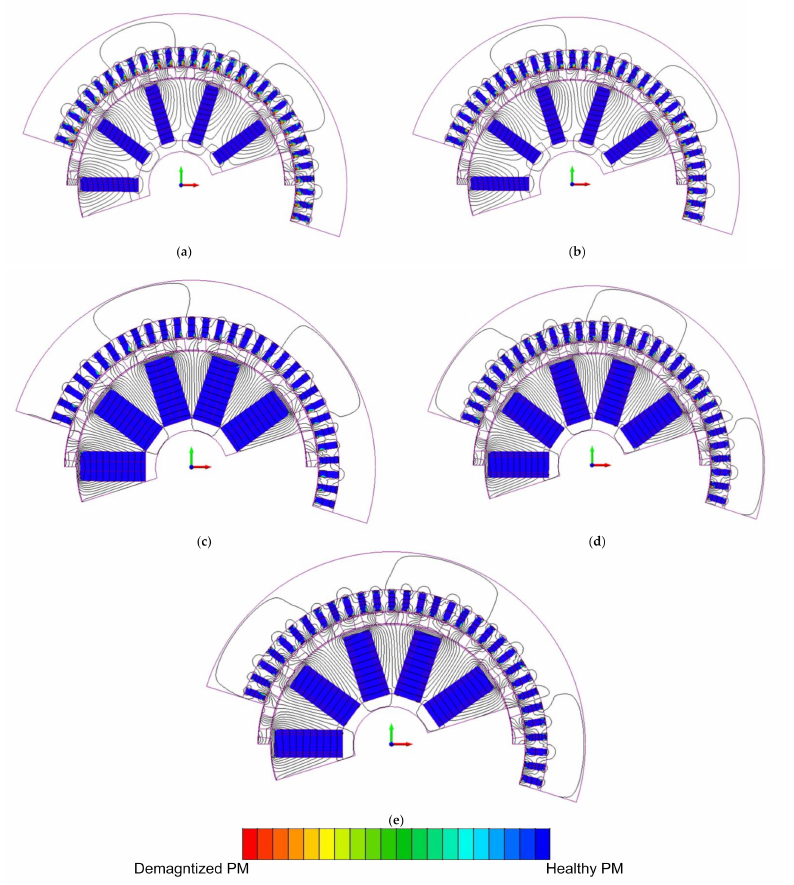
Figure 8. PM risk of demagnetization for various FM-CMG designs ( a ) Dy-NdFeB Design, ( b ) Dy-free NdFeB Design, ( c ) Ferrite Design, ( d ) Dy-NdFeB with Ferrite Design, and ( e ) Dy-free NdFeB with Ferrite